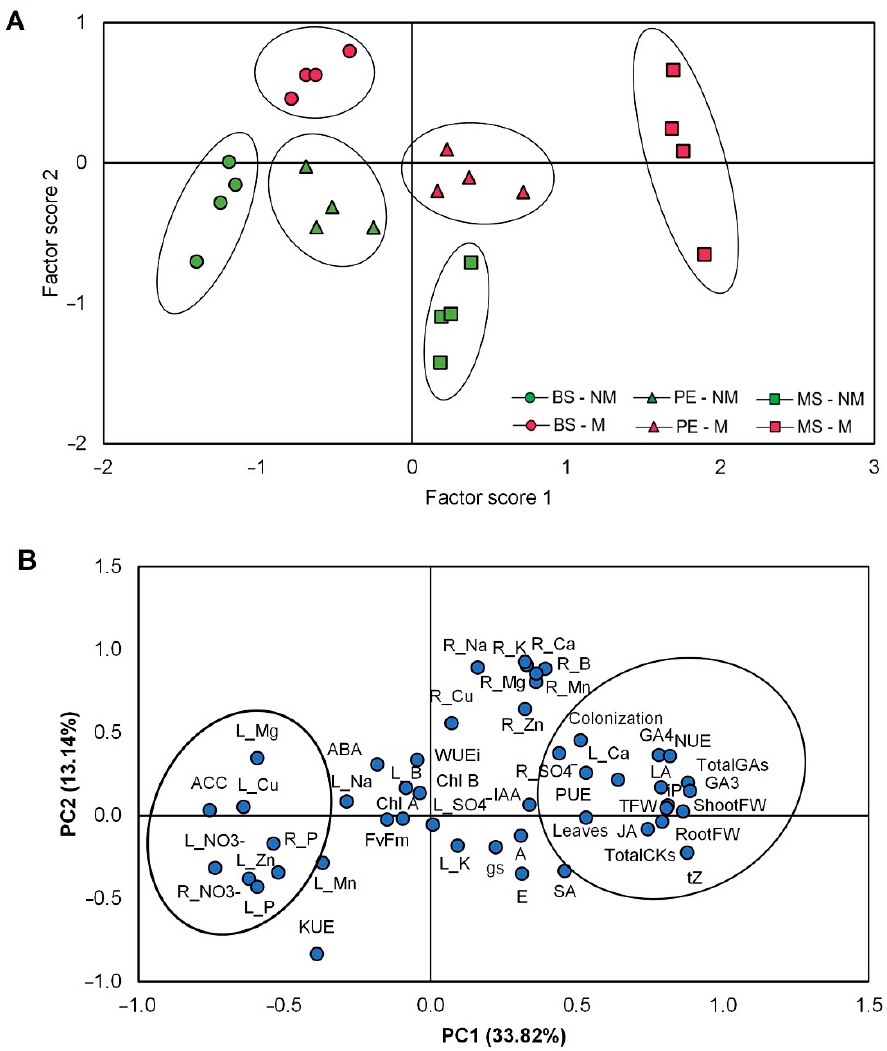
Figure 8. ( A ) Biplot representing the score values and ( B ) two axes of a principal component (PC1 and PC2) analysis showing the loadings of various growth-related, ionic, and hormonal variables (denoted by abbreviations) of the escarole commercial variety “Bekele” non-mulched or subjected to different mulching treatments and cultivated under non-mycorrhizal (NM) and mycorrhizal (M) conditions. Circles enclose those variables/scores that cluster together in loading PCA and score PCA. Abbreviations used: boron (B 3+ ), calcium (Ca 2+ ), copper (Cu 2+ ), potassium (K + ), magnesium (Mg 2+ ), manganese (Mn 2+ ), sodium (Na + ), phosphorus (P 5+ ), sulfate (SO 42 − ), nitrate (NO 3 − ), nitrogen use efficiency (NUE), phosphorous use efficiency (PUE), potassium use efficiency (KUE), root fresh weigh (RootFW), shoot fresh weight (ShootFW), leaf area (LA), total fresh weight (TFW), chloro-